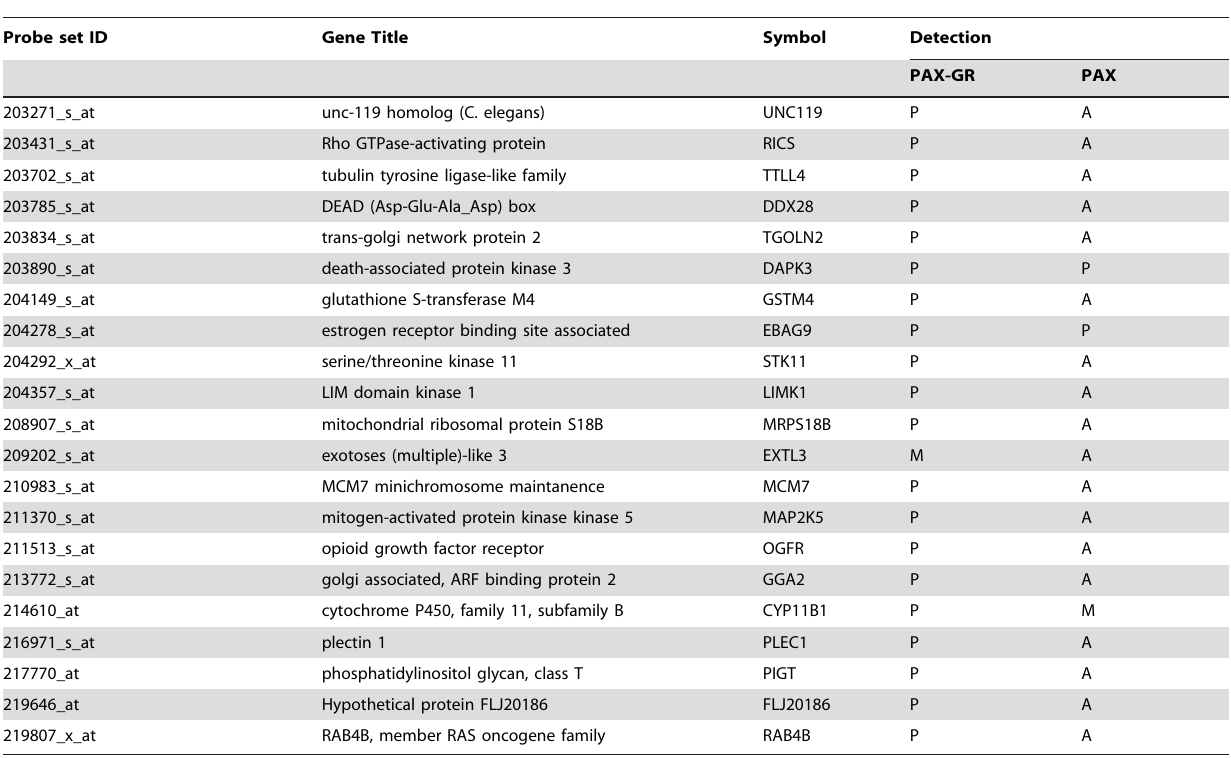
Table 2. Representative Genes masked by globins and unmasked in PAX-GR.